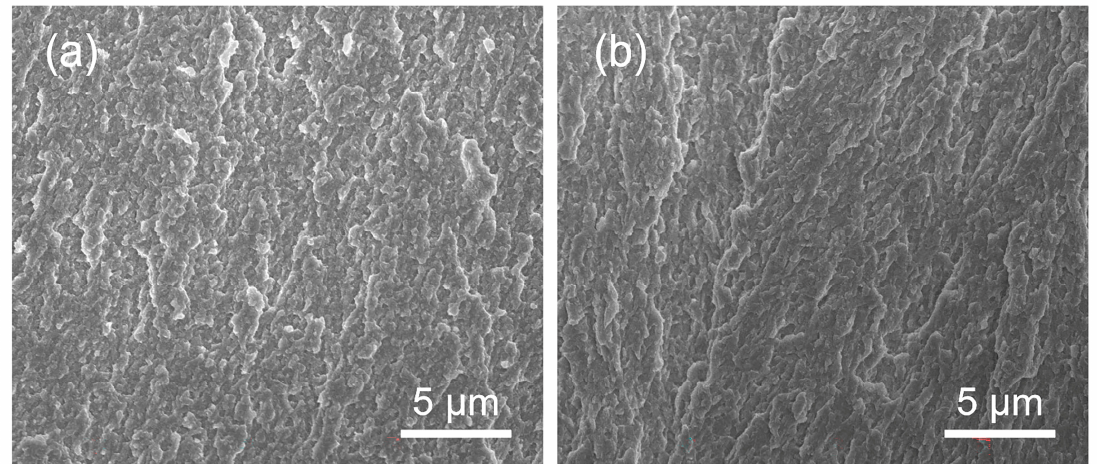
Figure 6. SEM of the cross-section of deposited coating: ( a , b ) are under 100 Hz and 1000 Hz, respec- tively.